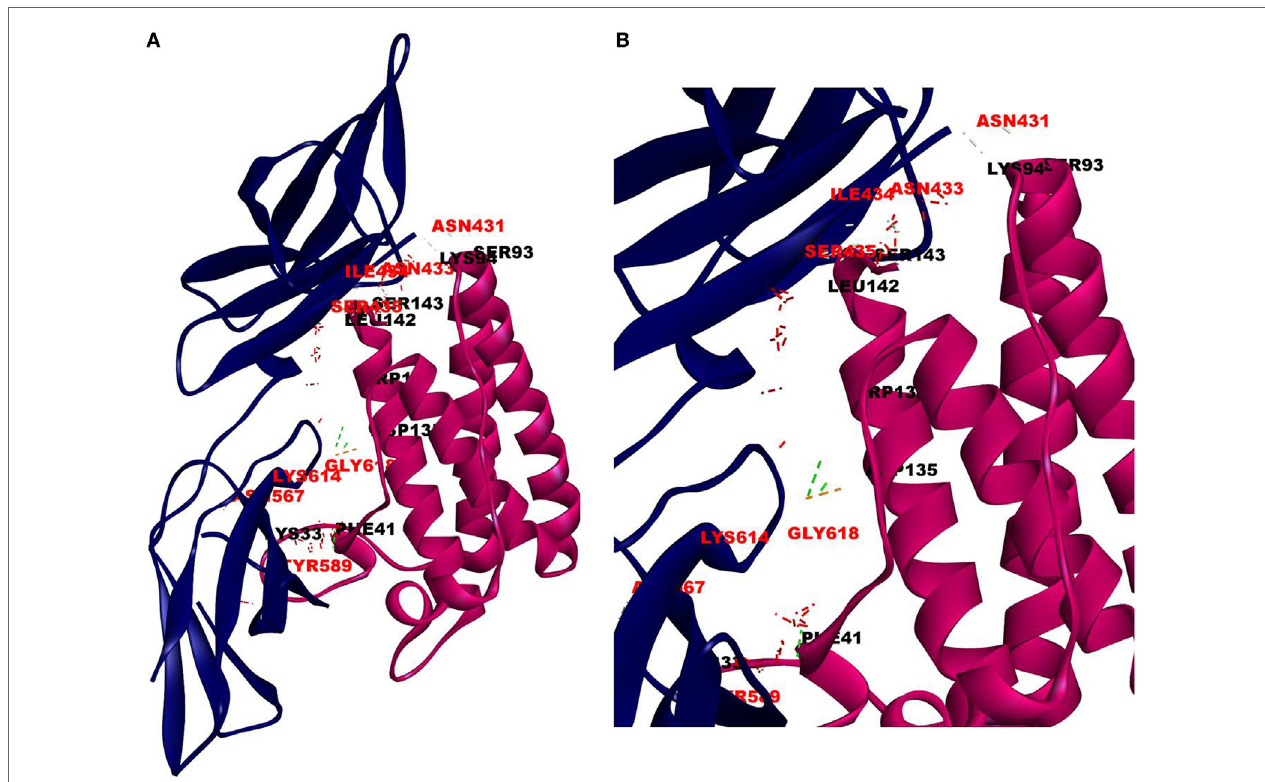
FigUre 2 | Docking of leptin to leptin receptor. Protein–protein docking was done between leptin and leptin receptor (CRH2, PDB ID 3V6O) as described in legends to Figure 1 . The image of the pose with the best Z -rank score in the largest cluster is shown in (a) leptin, PDBID-1AX8, (pink) docked (blind) with leptin receptor, PDB ID 3V6O, (CRH2 domain) (deep blue) and (B) enlarged image of docked amino acid